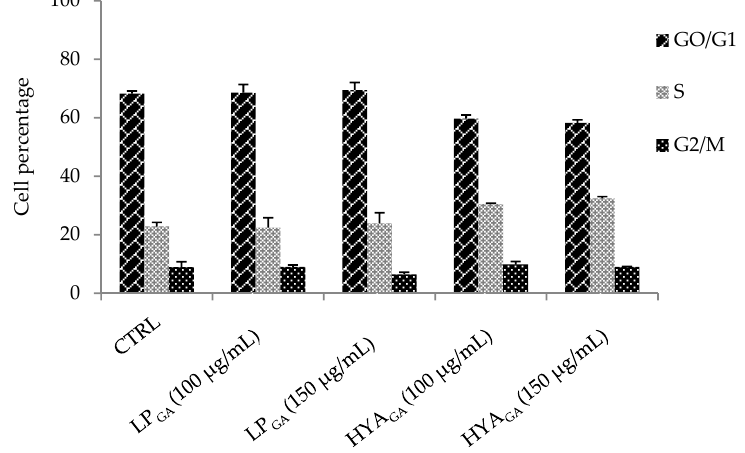
Figure 4. Cell cycle analysis of 3T3 cells treated with LP GA or HYA GA (100 or 150 μ g/mL phosphatidylcholine concentration) for 24 h. The histograms report the percentage of cells in the different phases of the cell cycle, evaluated by flow cytometric assay.